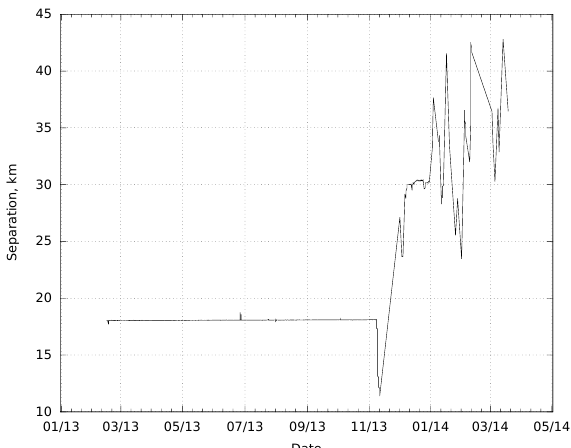
Figure 10. Distance separating each ADIOS